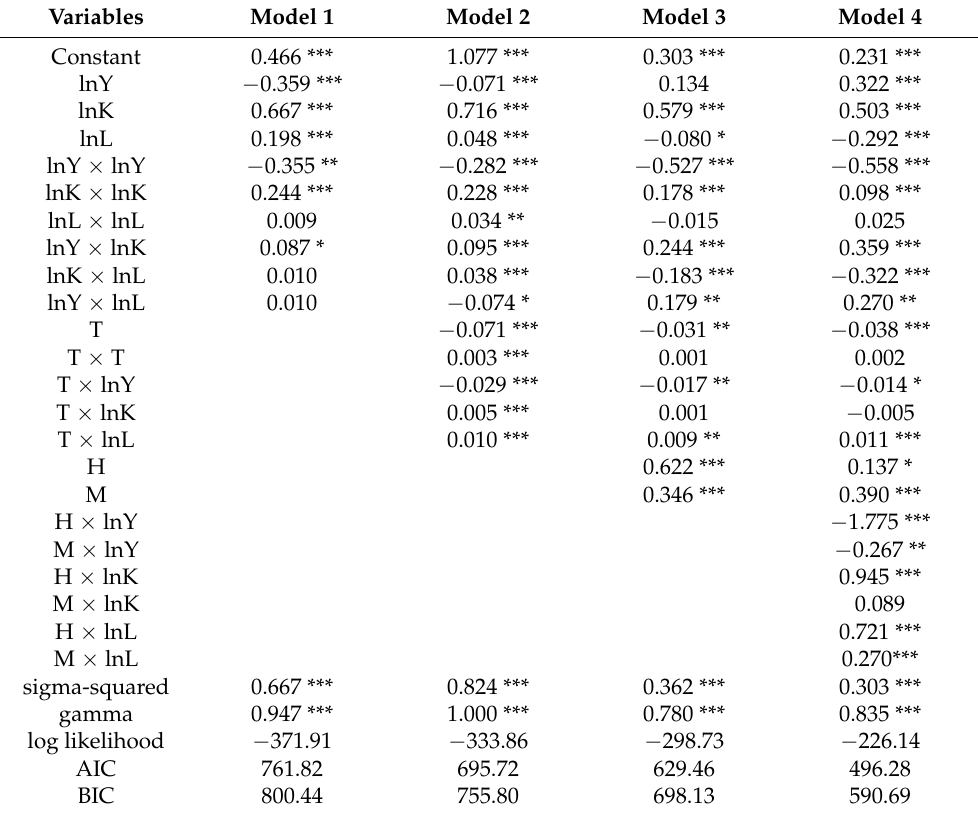
Table 1. Results of the